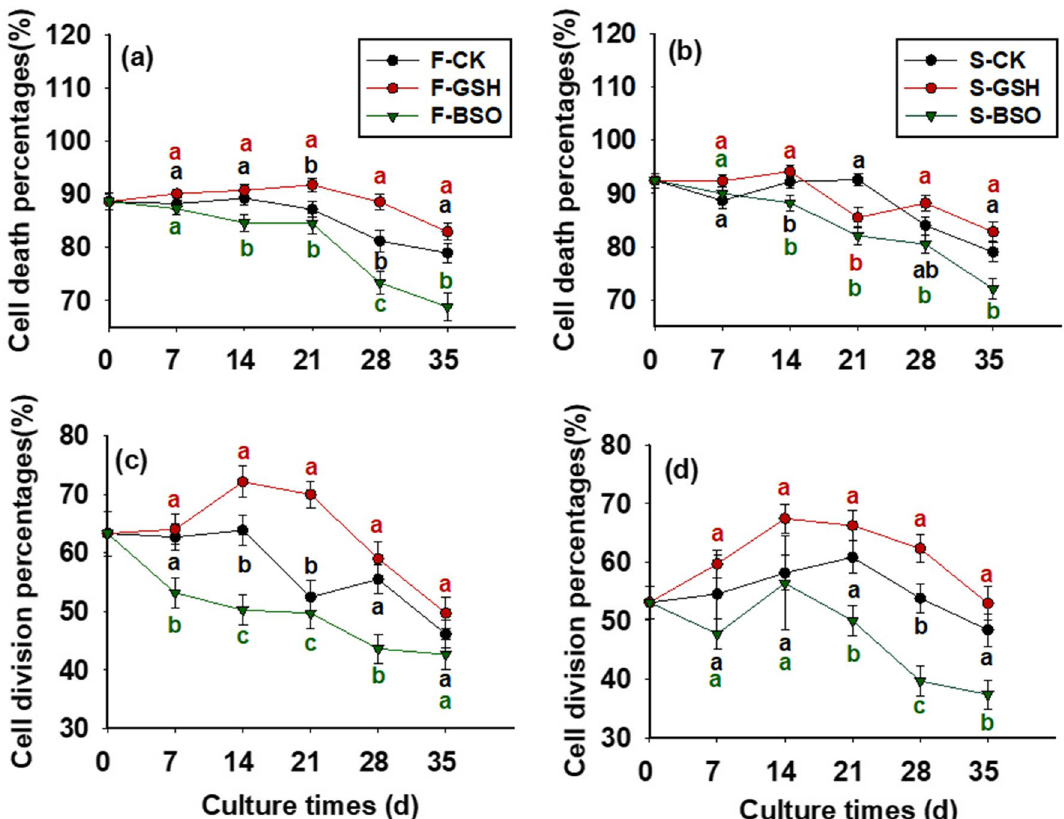
Figure 2. Effects of exogenous GSH and BSO on cell death and cell division percentages in two Korean pine cell lines. Note: F cell line control treatment (F-CK); F cell line exogenously supplemented with GSH (F-GSH); F cell line exogenously supplemented with BSO (F-BSO); S cell line control treatment (S-CK); S cell line exogenously supplemented with GSH (S-GSH); S cell line exogenously supplemented with BSO (S-BSO). ANOVA and Duncan’s test were performed on the data (Mean ± se) in the figure. Different lowercase letters at the same little figure indicate significant differences ( p < 0.05). Red lowercase letters indicate F-GSH and S-GSH treatment, black lowercase letters indicate F-CK and S-CK treatment, green lowercase letters indicate F-BSO and S-BSO treatment. The note of Figs. 3, 4 and 6 is the same as this